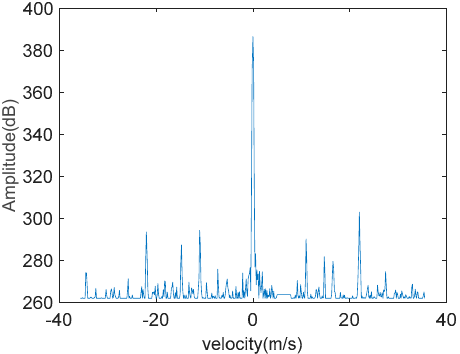
Figure 15. Regularization and main frequency alignment for DMS.